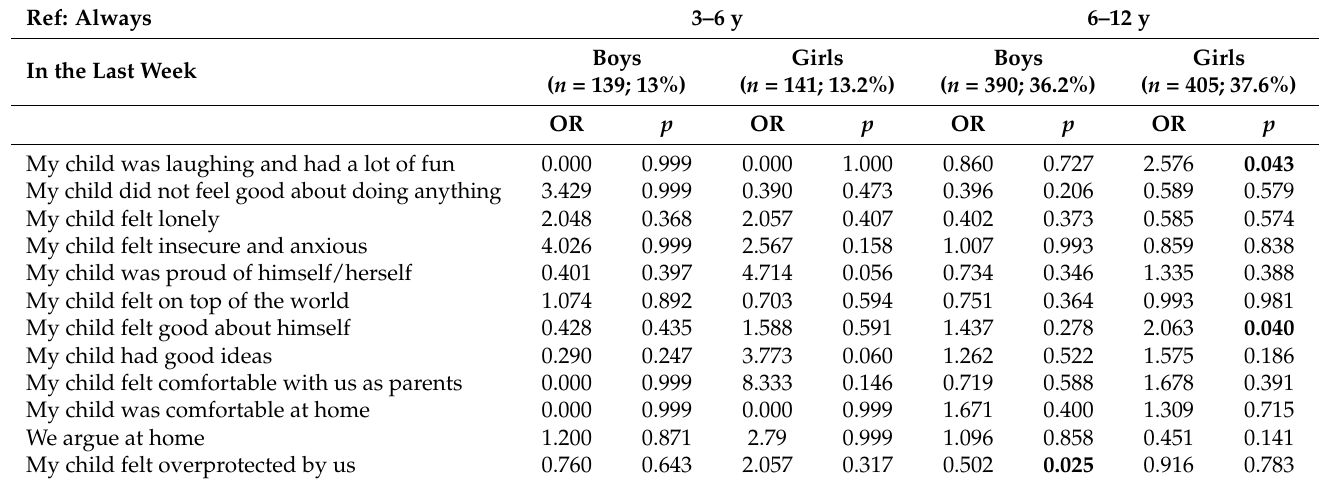
Table 5. Logistic regression analyses between different questions about the emotional well-being